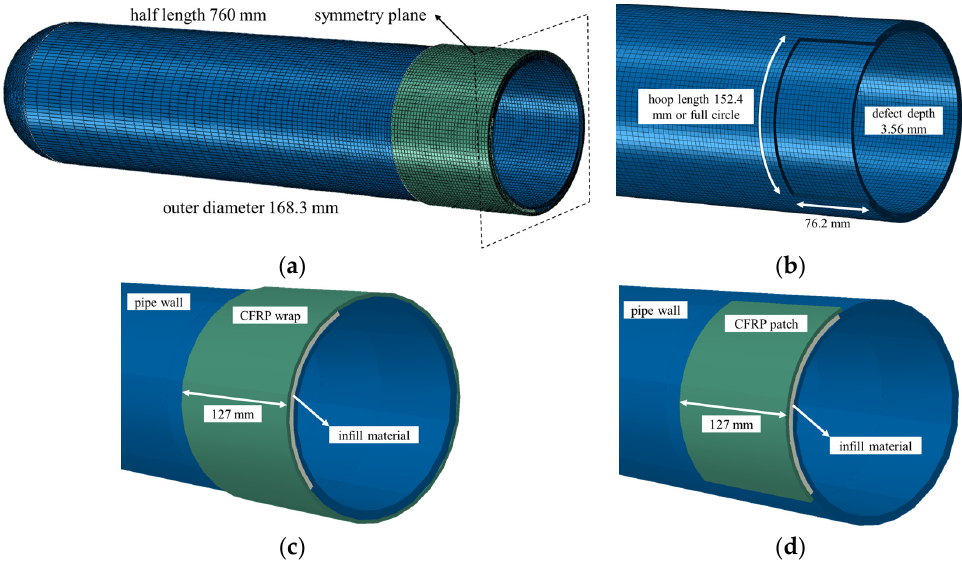
Figure 1. Model dimension: ( a ) whole model, ( b ) defect, ( c ) wrap repair, and ( d ) patch repair.